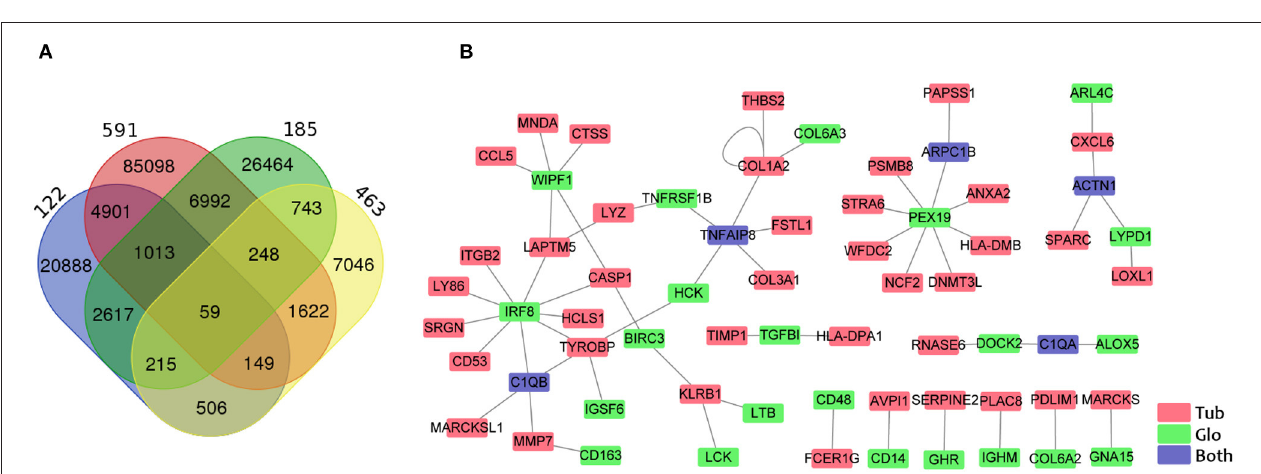
FIGURE 3 | Pathways for tubular and glomerular DEGs. (A) Venn diagram for the overlapping comparison of glomerular and tubular DEGs. Pathways of (B) glomerular and tubular overlapping DEGs, (C) tubular unique DEGs, and (D) glomerular unique DEGs. Significance is expressed as a p -value calculated using Fisher’s exact test ( p < 0.05) and shown as –log 10 ( p -value).